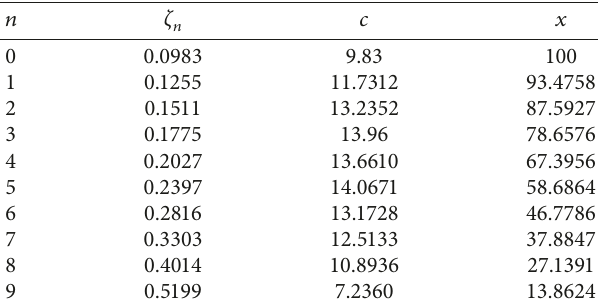
Table 2: Evolution of optimal consumptions and wealth processes